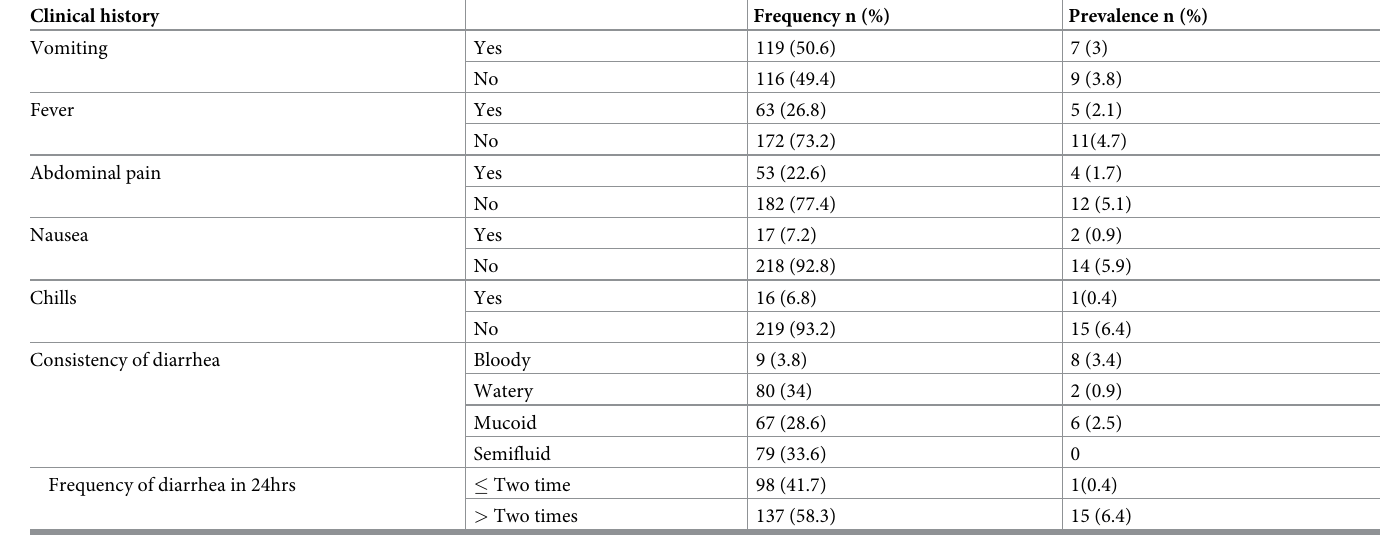
Table 3. Clinical characteristics and distribution of Campylobacter infection among under-five children at governmental hospitals in Hawassa city, Sidama, Ethio- pia, 2021. Clinical